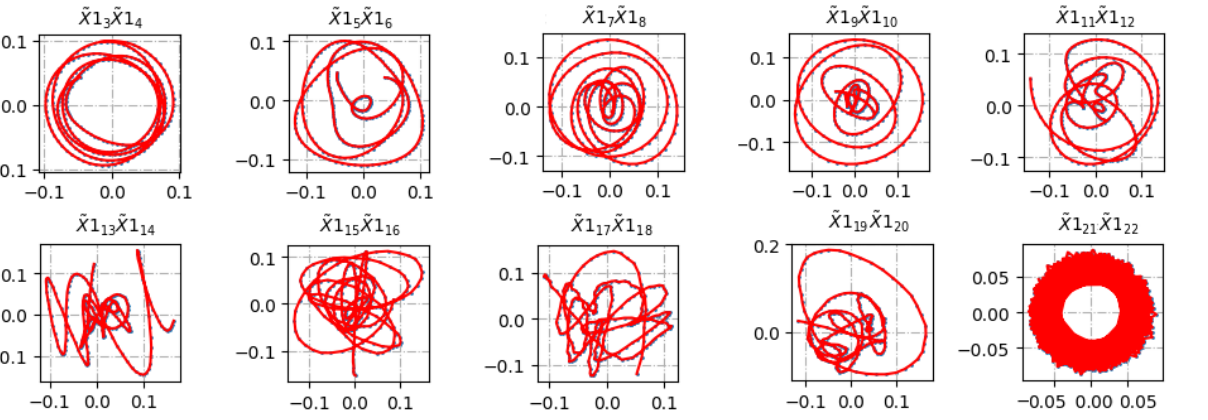
Figure 5. The scattergrams of pairs of eigenvectors.